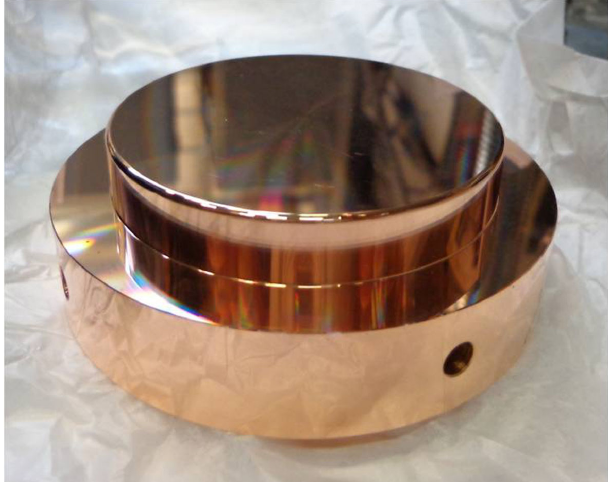
FIG. 1. An electrode used by the large electrode dc spark system. The interelectrode vacuum gap is formed between the top surface of the electrode and the same surface on an identical top electrode facing it symmetrically. The outer rim of the electrode supports the ceramic spacer that holds the electrodes apart and determines the vacuum gap distance. Electrode edges are gently rounded (rounding radius 1 mm) to prevent breakdown through the ceramic and to reduce field enhancement by the